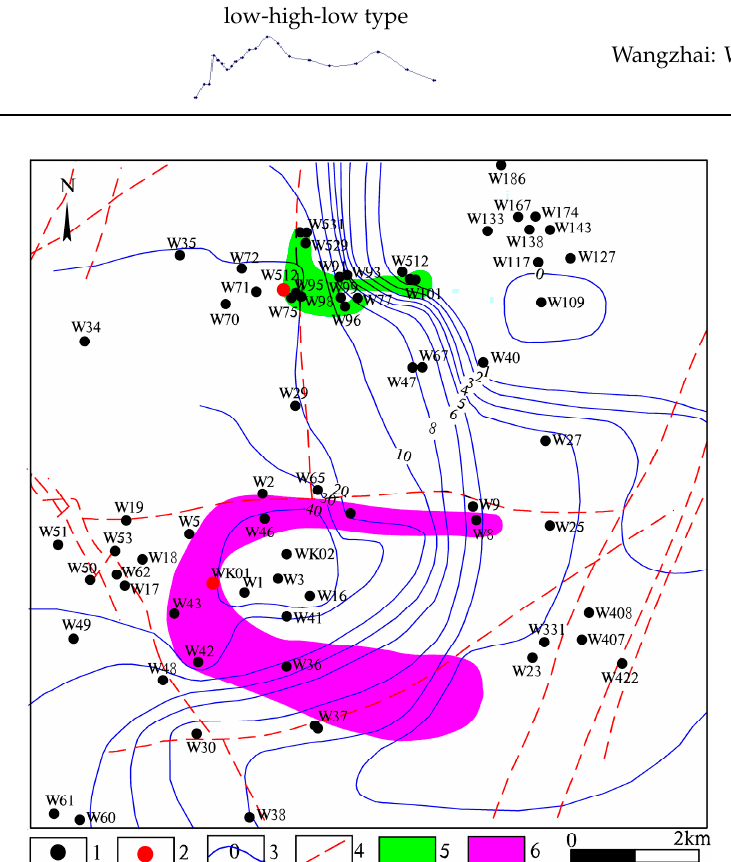
Figure 2. The range of tracer diffusion. 1 : Observation well; 2: Source well; 3: Water level line/m; 4: Fault; 5: Tracer diffusion zone in Wangzhai; 6: Tracer diffusion zone in Hougao.